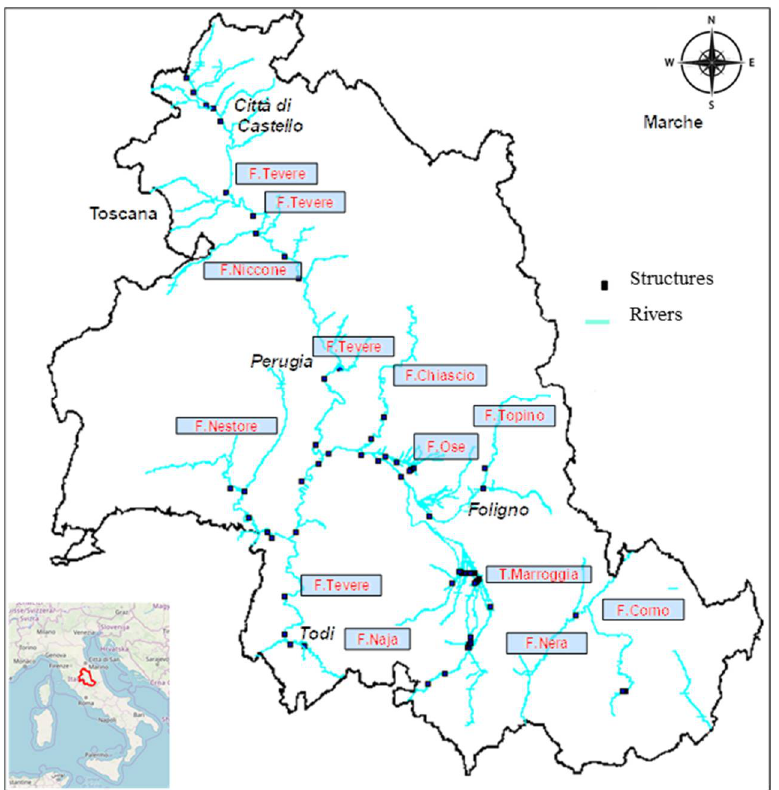
Figure 6. Map of the studied structures in the Province of Perugia. Light blue identifies river reaches (the name is indicated in red).